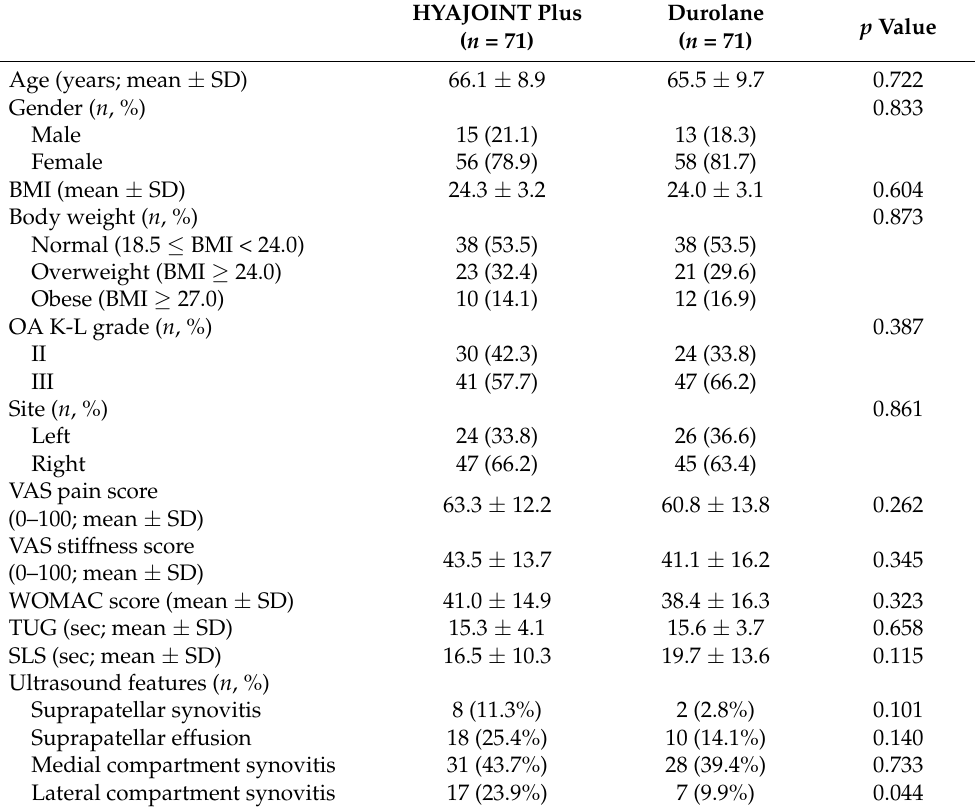
Table 2. Demographic data and baseline characteristics.